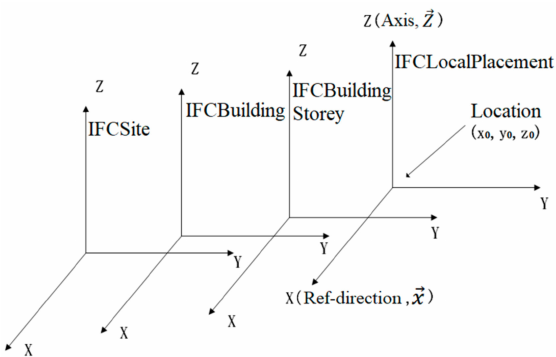
Figure 6. Relationship of coordinate